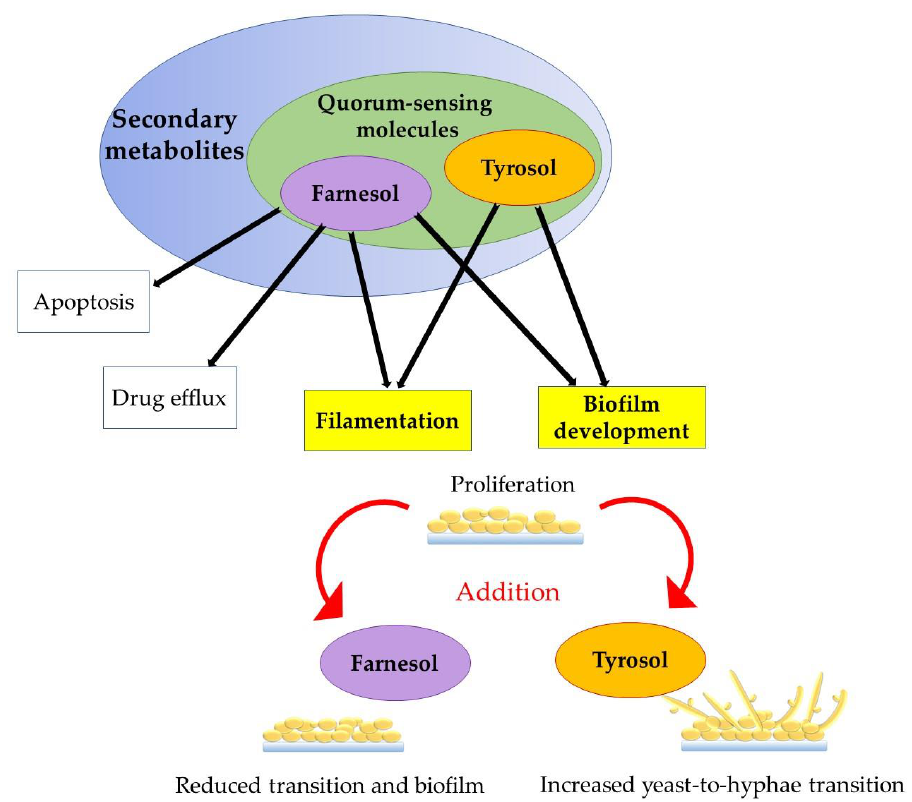
Figure 2. Role of externally added Far and Tyr to the proliferation stage as an important biofilm growth phase.